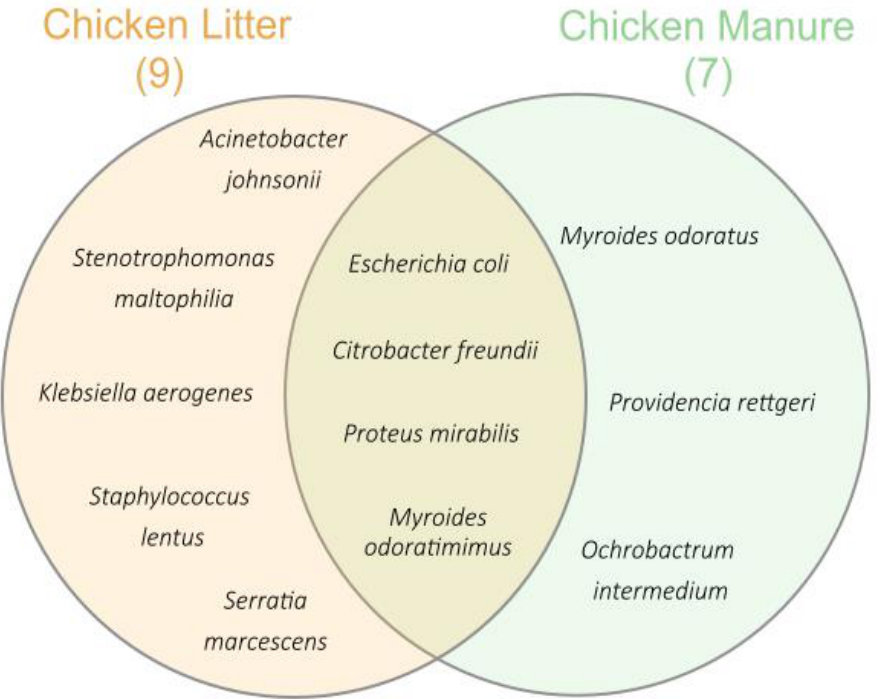
Figure 1. Venn diagram presenting the differences in bacteria species found in two analyzed types of chicken waste—CM and CL; nine bacteria species were detected in CL and seven in CM.